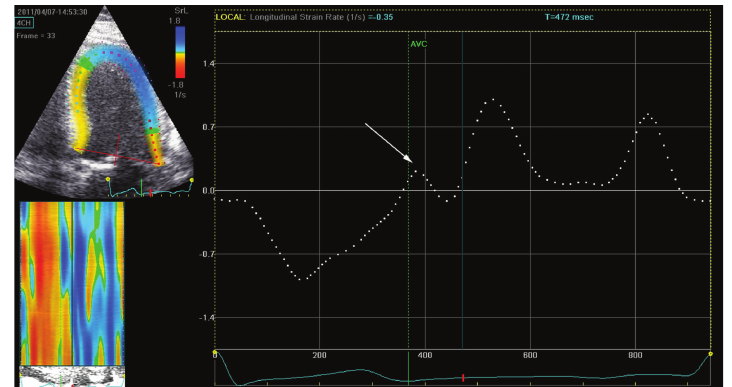
Figure 1: Evaluation of peak strain rate during left ventricular isovolumetric relaxation period SR IVR from the apical 4-chamber view. First, a region of interest which includes the entire left ventricular wall is obtained (left-upper panel). The software consequently displays the changes in longitudinal strain rate over the cardiac cycle (white dotted line). Left ventricular isovolumetric relaxation occurs in diastole, starting immediately after closure of the aortic valve and terminating with the beginning of the diastolic early ( E ) wave. The peak strain rate value during the isovolumetric relaxation period (SR IVR ) is consequently measured (indicated by the white arrow). The green dotted line indicates the timing of the aortic valve closure